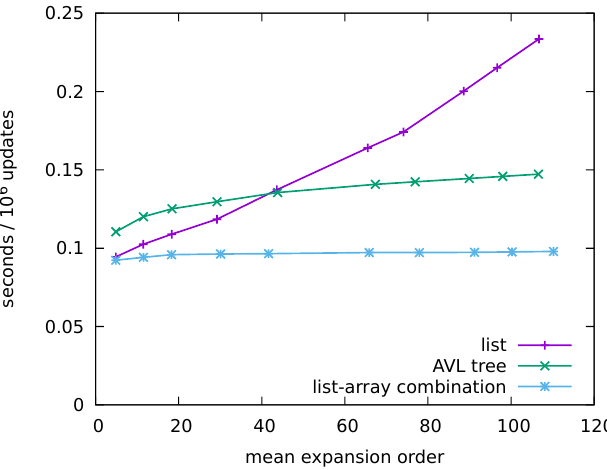
Figure 8: Benchmark of different diagram data structures. To provoke large expansion orders, α = 1 has been used and imaginary times reached as far as τ has been tuned from very close to the polaron energy, µ = − 1.02 (high expansion order), to µ = − 1.2 (low expansion